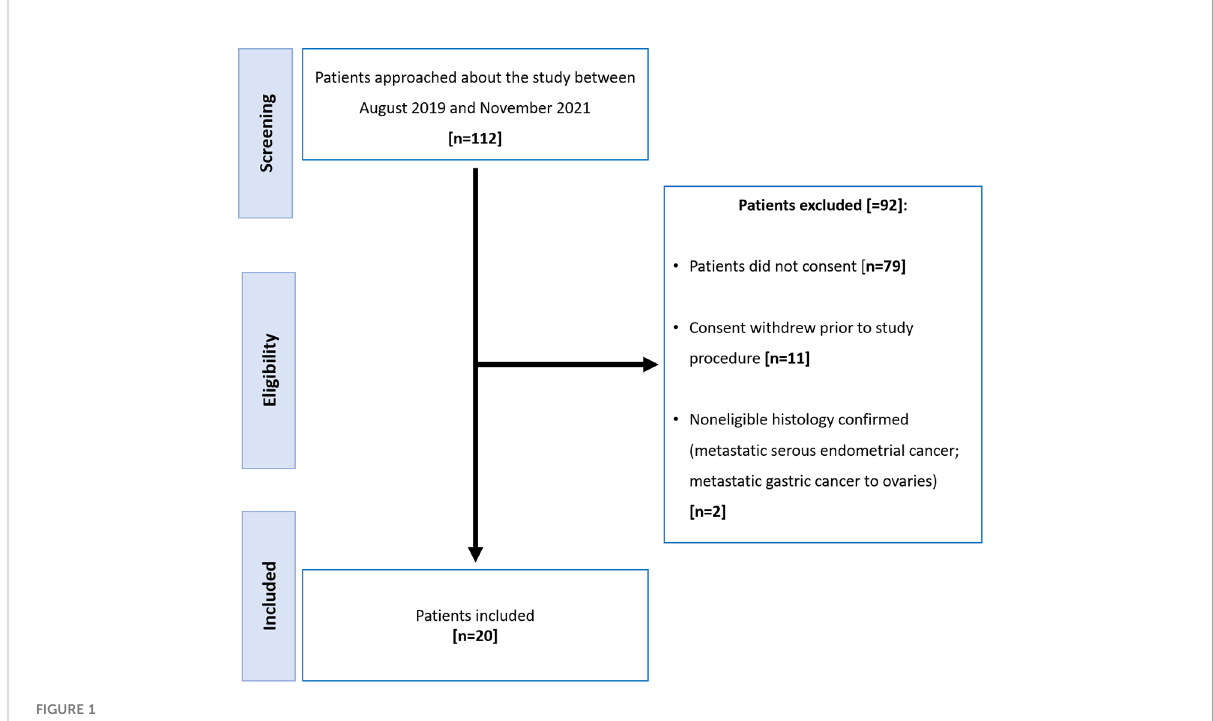
FIGURE 1 Patient fl owchart.